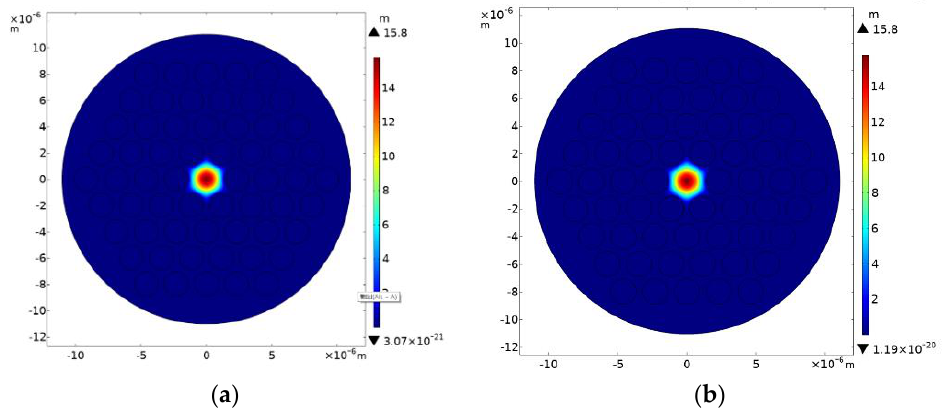
Figure 4. Distribution of acoustic fundamental mode in the proposed ( a ) filled and ( b ) unfilled PCF at 20 °C.